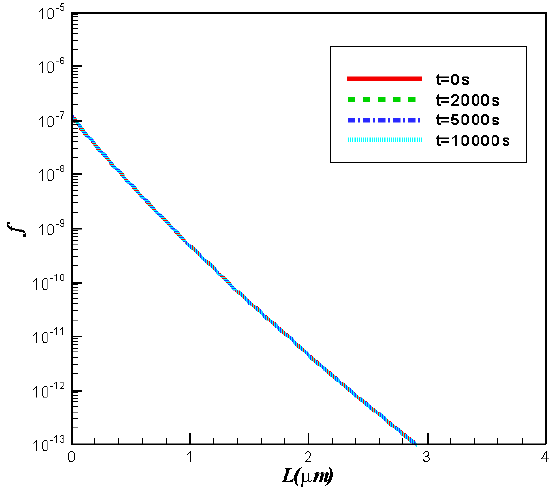
Figure 7. Evolution of CSD obtained using the Chebyshev spectral collocation method.